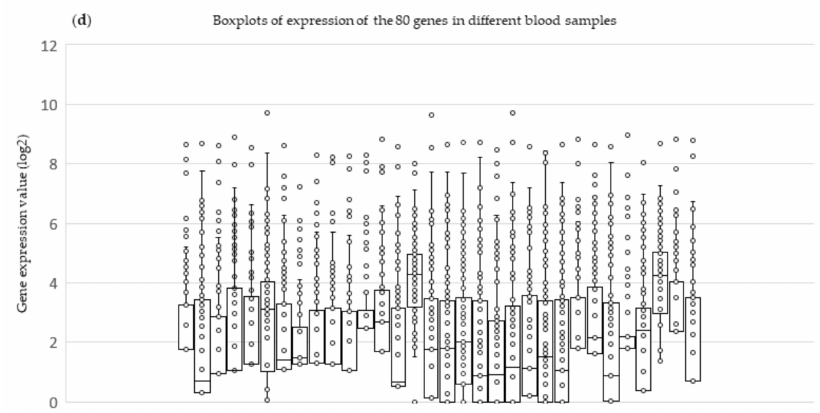
Figure 2. Experimental validation in breast cell lines, breast tissue, and blood samples. ( a ) Heatmap showing the expression levels of the 80 genes in breast lesions samples compared to the expression levels of breast cell lines and blood from patients with conditions other than cancer. ( b ) Boxplots showing the expression levels for each cell line available. ( c ) Boxplots showing the expression levels for each breast lesion (benign and malignant). Boxplots show the expression of the 80 genes in 44 breast tumors, including benign ( n = 8) (gray boxes) and malignant lesions ( n = 36) (white boxes). The means of expression (log2) are visible between 8 and 10. ( d ) Boxplots showing the expression levels for each blood sample (bu ff y coat). The boxplots show the expression of the 80 genes in 32 bu ff y coats from cases with conditions other than cancer. The expression means (log2), for the most part, are visible below